Question: Briefly state, in one sentence, what is plotted here.
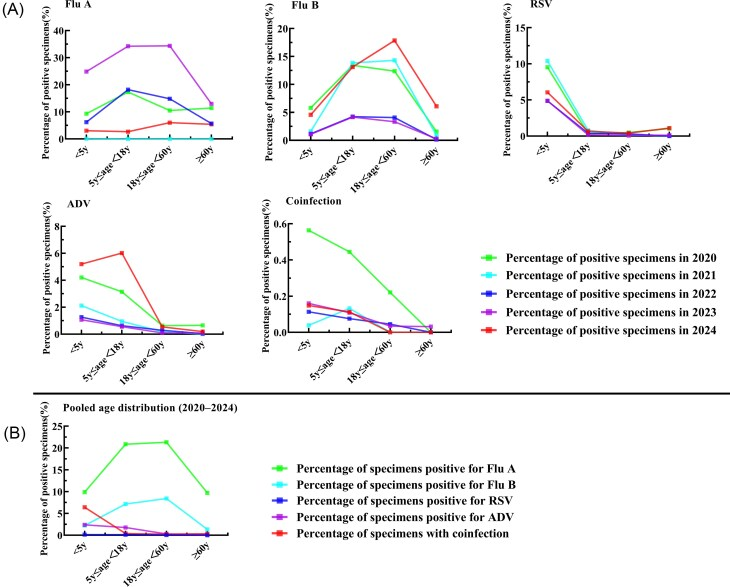
Answer: Age-stratified trends of four major respiratory viruses and coinfections from 2020 to 2024. (A) Age-stratified distribution of positivity rates by year (2020–2024). Subpanels show Flu A, Flu B, RSV, ADV, and coinfection. Each line represents one study year. (B) Pooled age-stratified distribution (2020–2024). Each line represents the pooled age-stratified distribution of positivity rates across the entire 5-year study period for Flu A, Flu B, RSV, ADV, and coinfections.